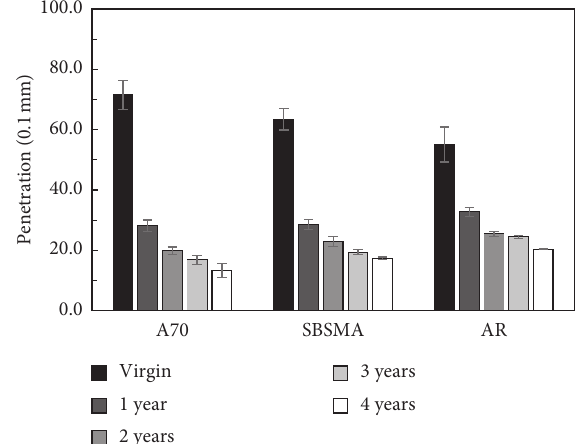
Figure 3: Penetration of asphalt with different weathering time. Table 3: Residual penetration ratio of asphalt. Asphalt